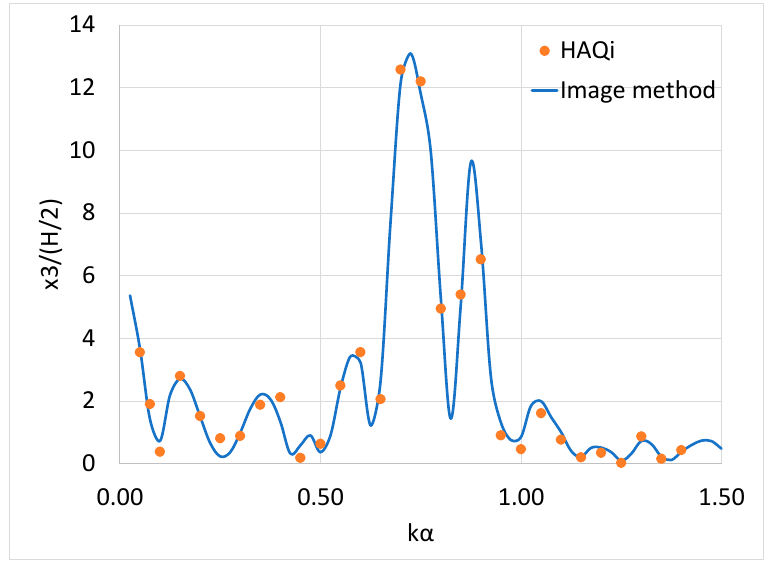
Figure 5. Heave motions of a converter placed in front of a 60-degree V-shaped breakwater. The results of the method of images are compared with the corresponding ones from an analytical formulation assuming a finite length breakwater. Here, B pto =